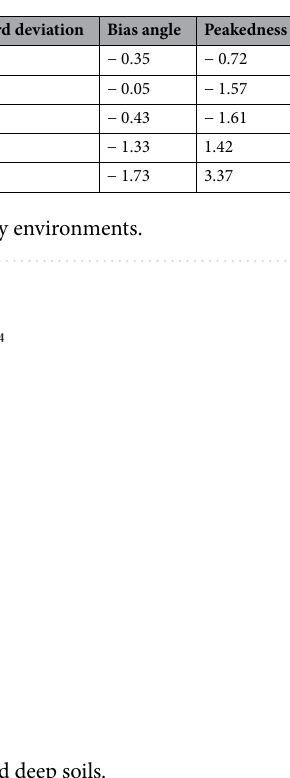
Figure 4. Trend of fractal dimension of the shallow, middle, and deep